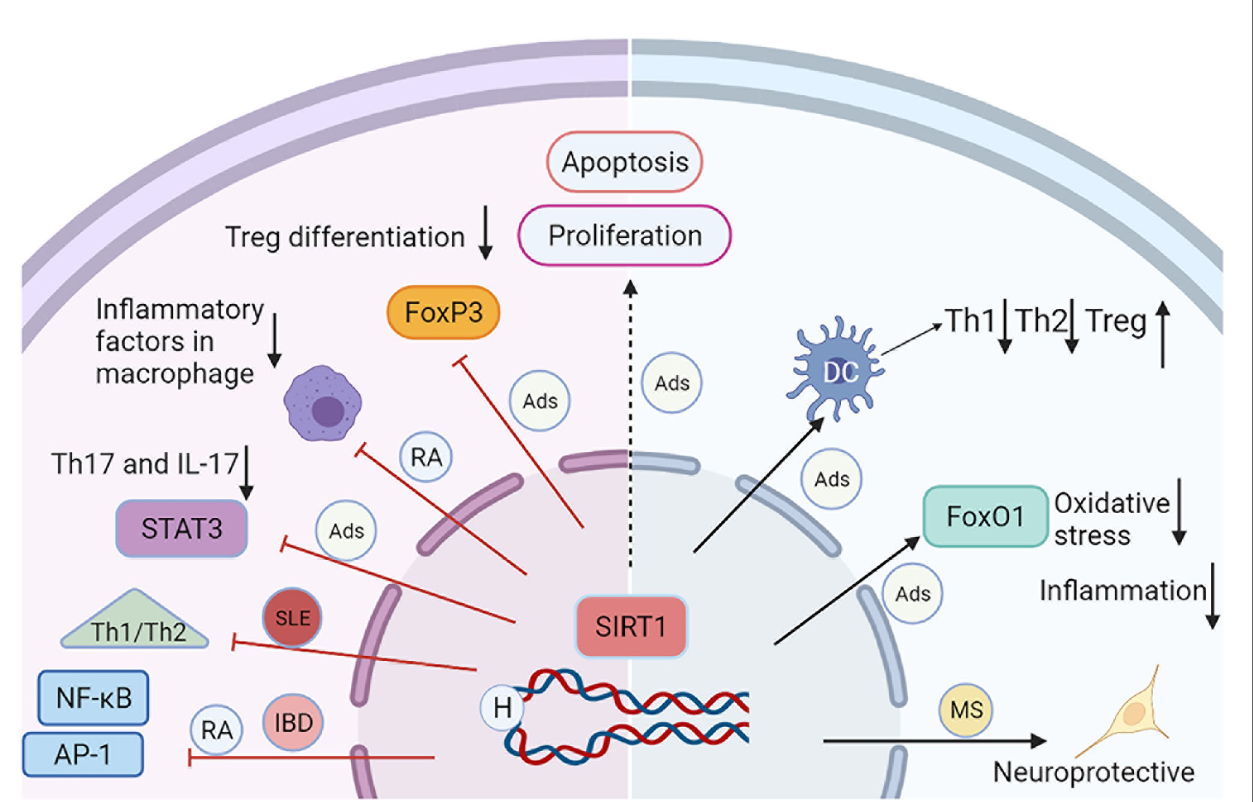
FIGURE 1 | A schematic diagram illustrating the major mechanisms of SIRT1 in selected autoimmune diseases. The activation of SIRT1 reduces the acetylation and activation of transcription factors, such as NF-kB, STAT3, AP-1, and FoxP3, leading to decreased in fl ammation, and apoptosis. SIRT1 can inhibit in fl ammation and oxidative stress through the deacetylation of FoxO1. SIRT1 also regulates DC-mediated Th1, Th2, and Treg immune responses. All these processes interact each other and contribute to the progression of